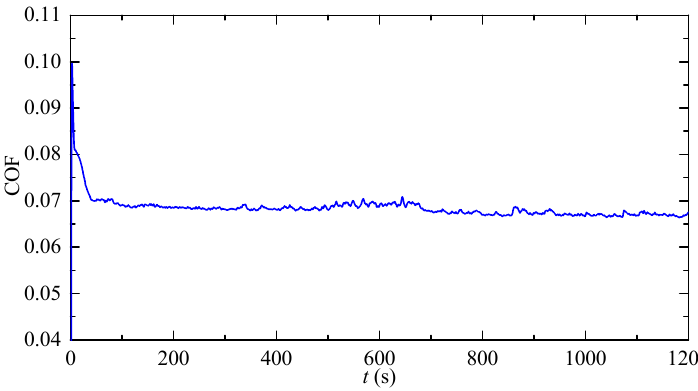
Figure 4. The friction curve of the DLC-coated sample.